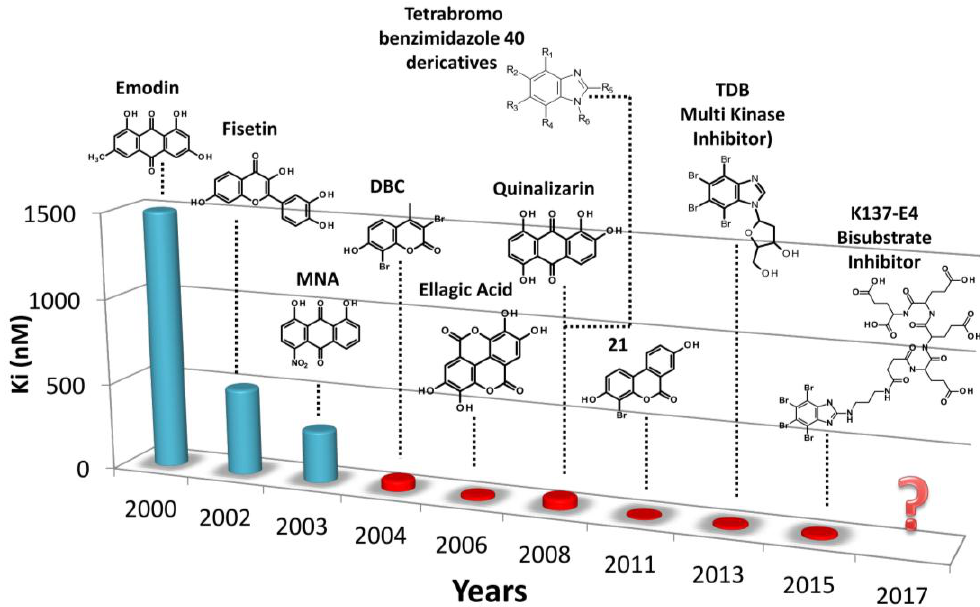
Figure 9. Activity of CK2 inhibitors over time expressed in Ki; blue bars represent the inhibition constant of compounds identified through random screen campaign of chemical compounds (“trial and error testing”), red bars the ones of compounds discovered through in silico rational drug design.